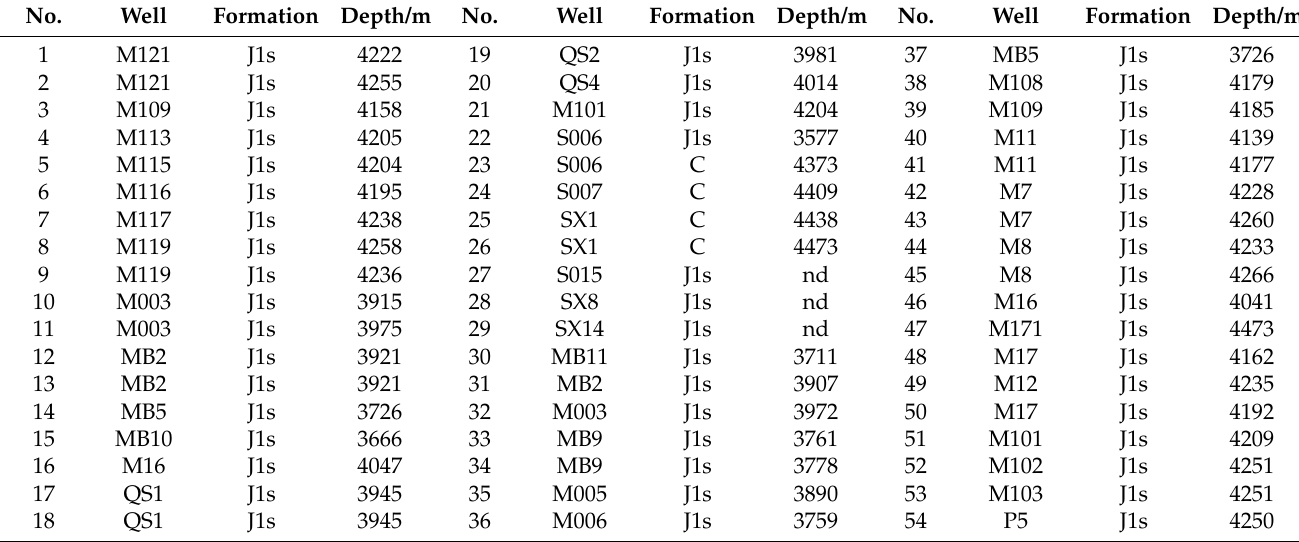
Table 1. Depth and source of natural gas